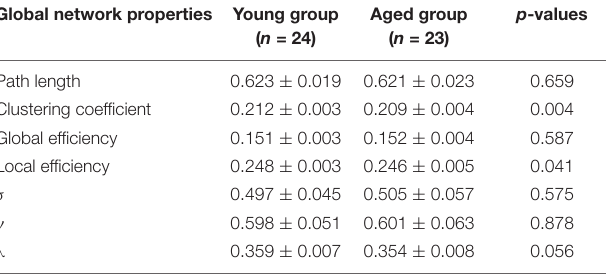
TABLE 1 | Intergroup differences of global network